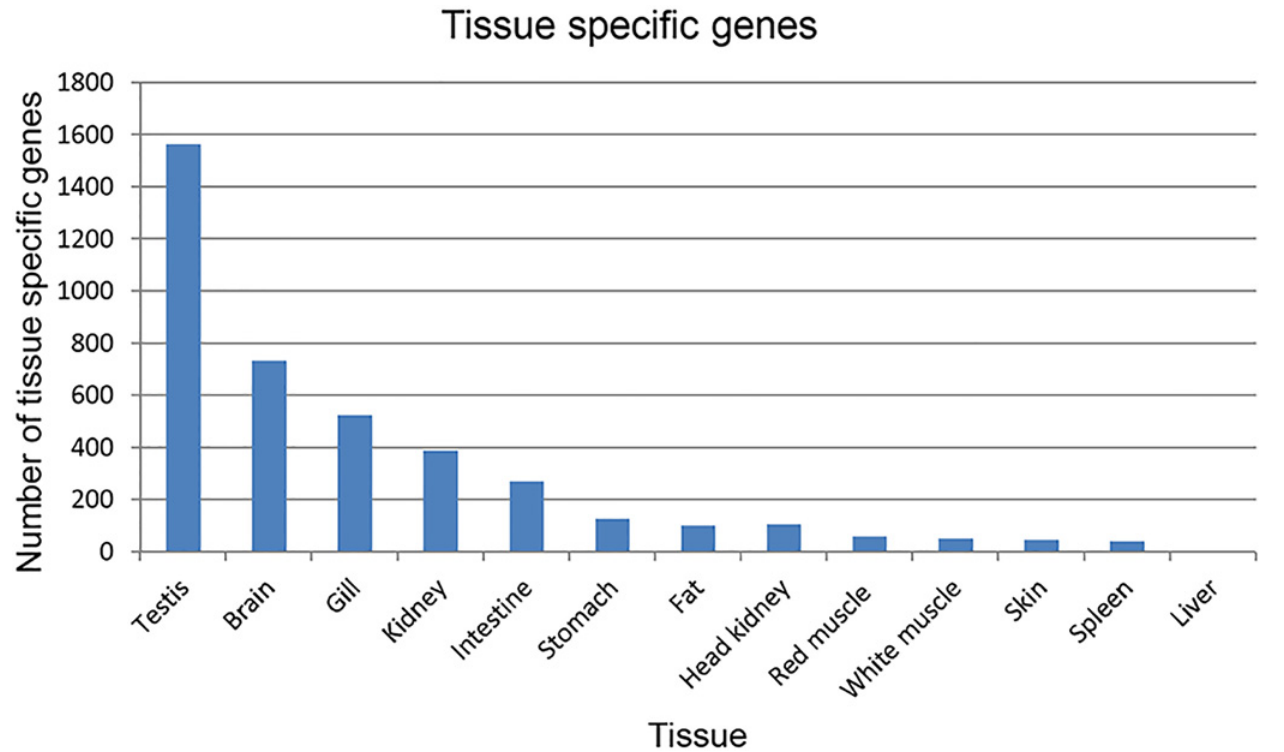
Fig 6. Number of tissue-specific genes predicted in different tissues. A transcript was classified as tissue-specific if it had an expression level in one tissue that is (cid:1) 8 fold higher in all other tissues.